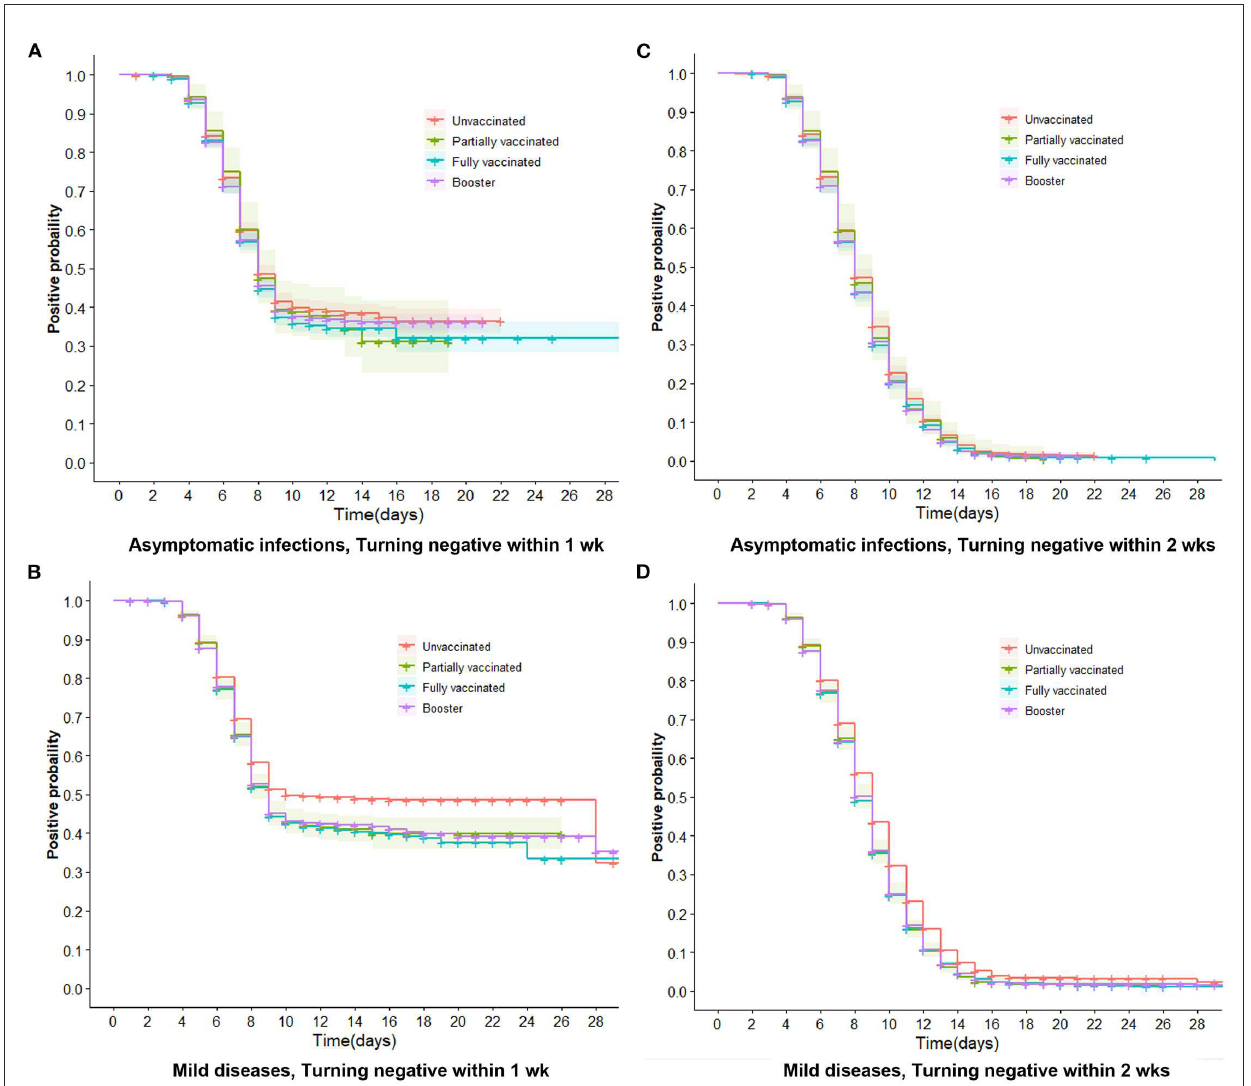
FIGURE4 Trends of negative conversion within 1 week and 2 weeks in asymptomatic infections and mild diseases. Trends of negative conversion among four vaccine groups were analyzed by the Cox regression. Curves of four types of vaccinations are similar and close together for turning negative within 1 week and 2 weeks in asymptomatic infections (A, C) . The booster, full, and partial vaccination curves are lower than the unvaccinated curve (B, D) , indicating that vaccinated individuals have a faster decline in viral RNA levels than unvaccinated individuals ( P < 0.001).